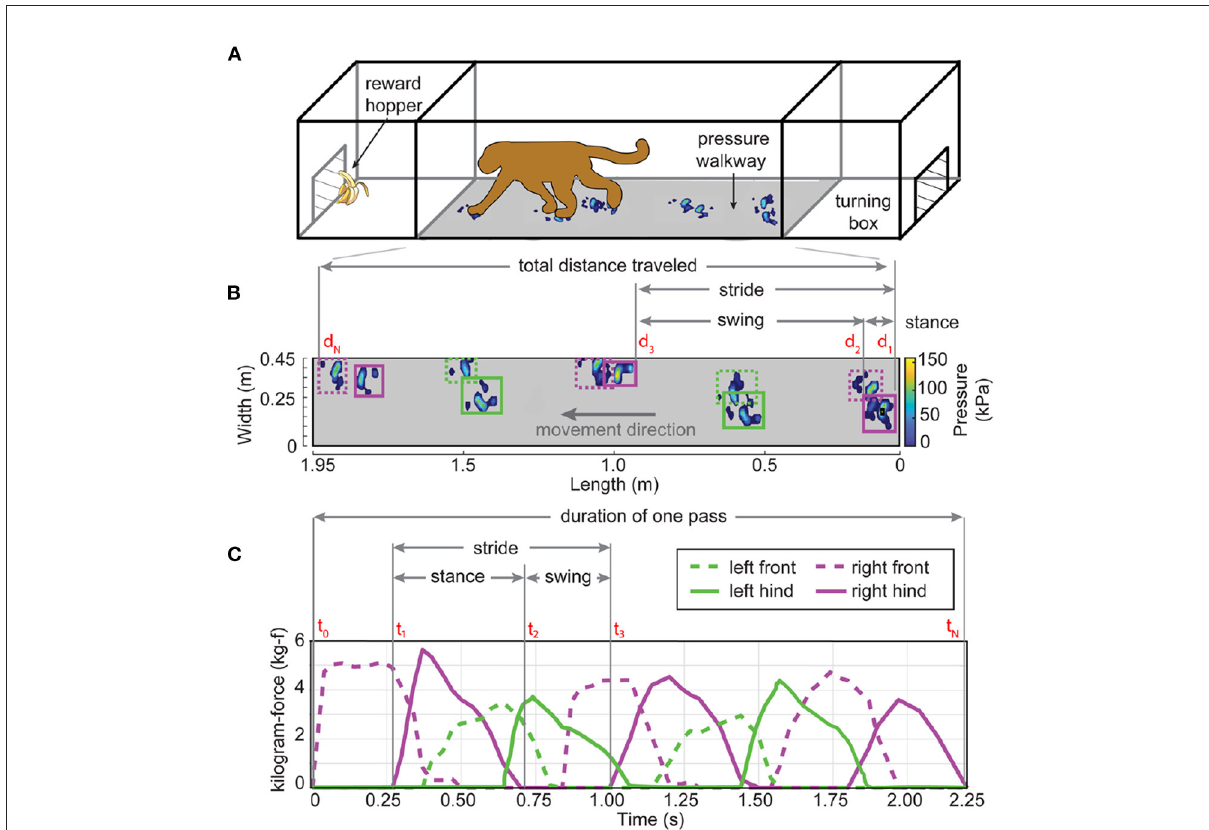
FIGURE2 Gait testing apparatus and spatiotemporal analysis of gait parameters. (A) The GTA consists of a tunnel capped at each side by end enclosures with sliding doors (not shown). A pressure mat (gray shaded area) recorded location, time, and magnitude of contact pressure (pixelated blue hand and foot prints). Food or juice reward was delivered through hoppers in each end enclosure. (B) Overhead perspective of pixelated calibrated pressure data (color bar, kPa) recorded for a representative pass/trial from right-to-left. Post-processed ‘strike-boxes’ placed around each hand or foot print identified contact points and pressure magnitudes by limb (front/hind limbs shown as dashed/solid lines, respectively, and left/right sides shown in green/purple, respectively). Interlimb distance is the length between leading edges of consecutive ipsilateral limb “strike boxes”. (C) Time series of the aggregate pressure data converted into kilogram-force (kg-f) captured within each ‘strike-box’ defined temporal gait parameters and stance force profiles for each limb. The representation of the first stance, swing, and stride progression shown from right-to-left (B) is the same instance shown from left-to-right in the time series. Time and distance variables (red) are illustrated for each gait parameter, see Table